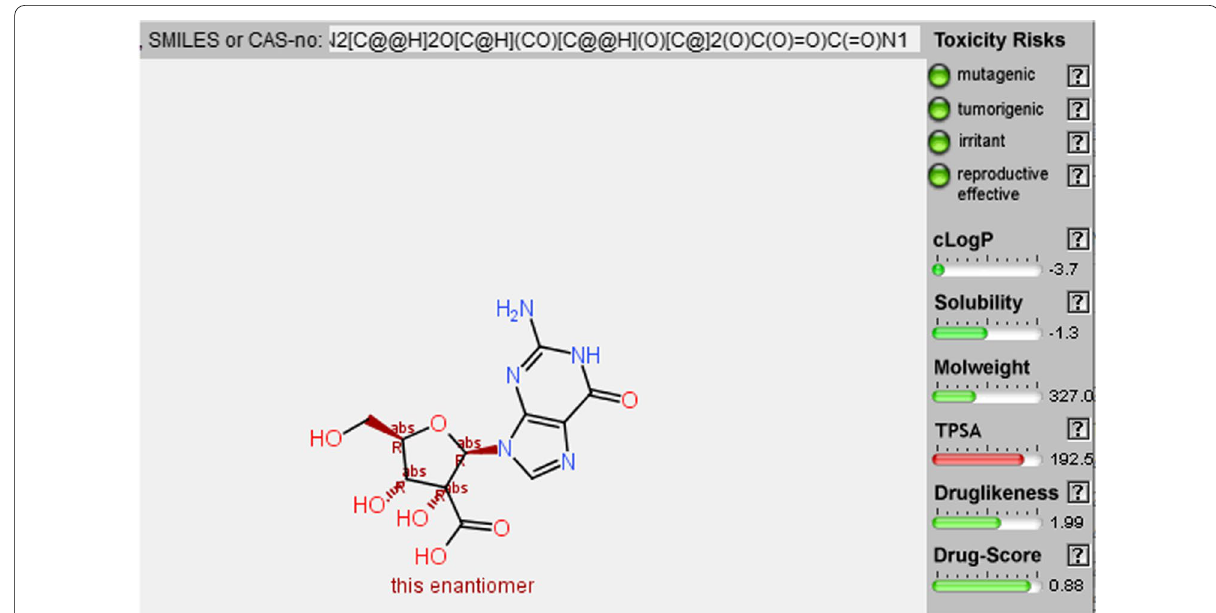
Fig. 6 Side view of the compound 1c on the OSIRIS Property Explorer interface showing physicochemical characteristics including Toxicity Risks